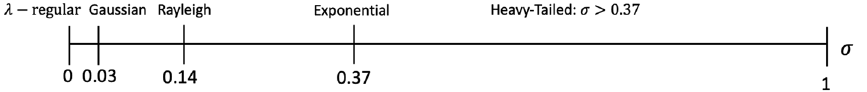
Fig. 2 Number line for heterogeneity that highlights the special cases corresponding to canonical